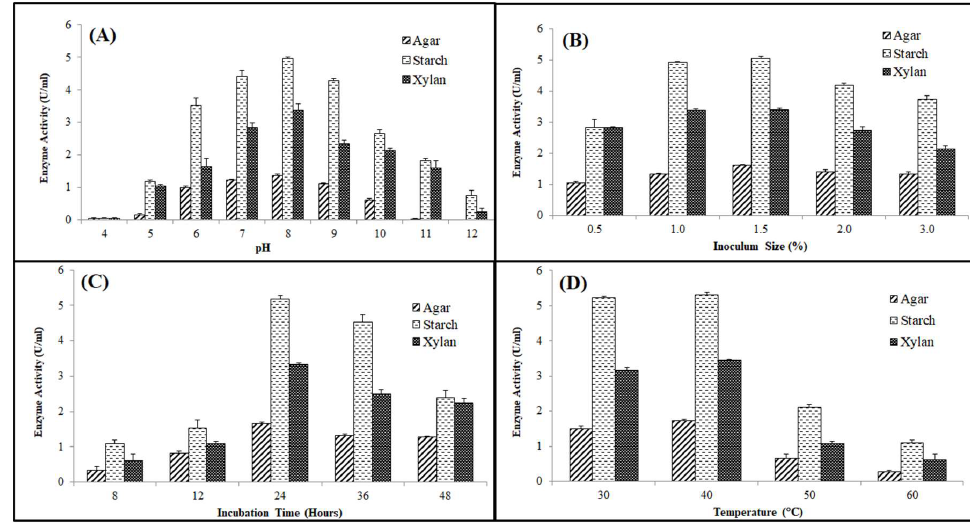
Figure 3. Effect of the key cultural parameters: ( A ) pH ( B ) Inoculum size ( C ) Incubation time ( D ) Temperature on enzyme